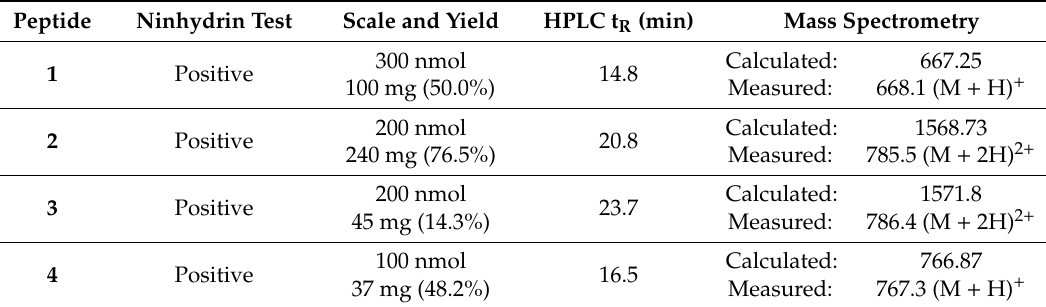
Table 2. Synthetic peptide identification and